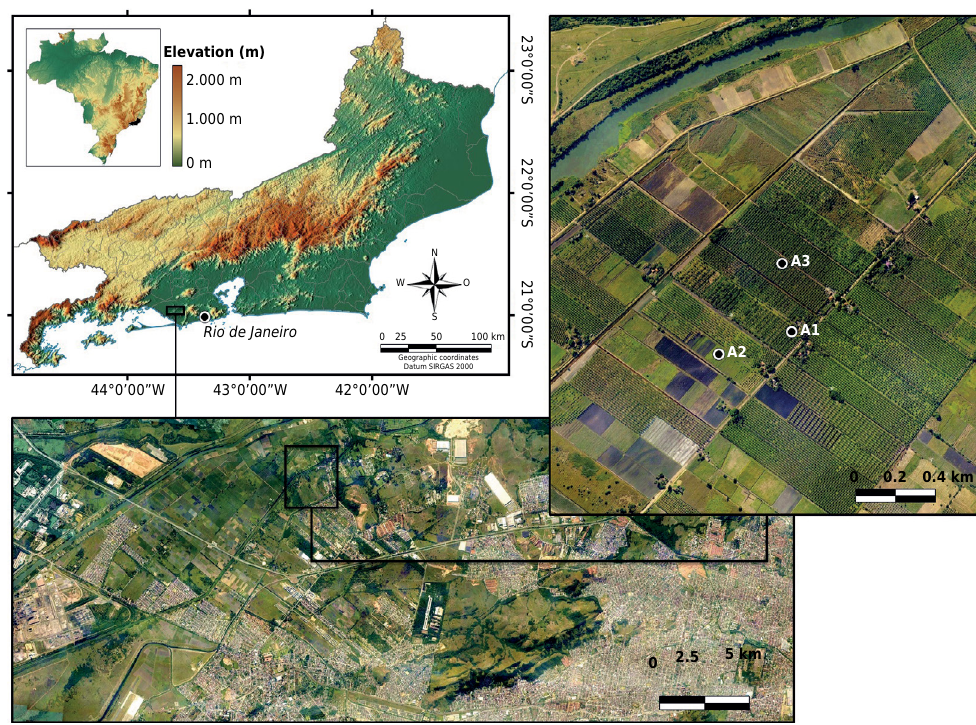
Figure 1. Location of study areas in the municipality of Rio de Janeiro,